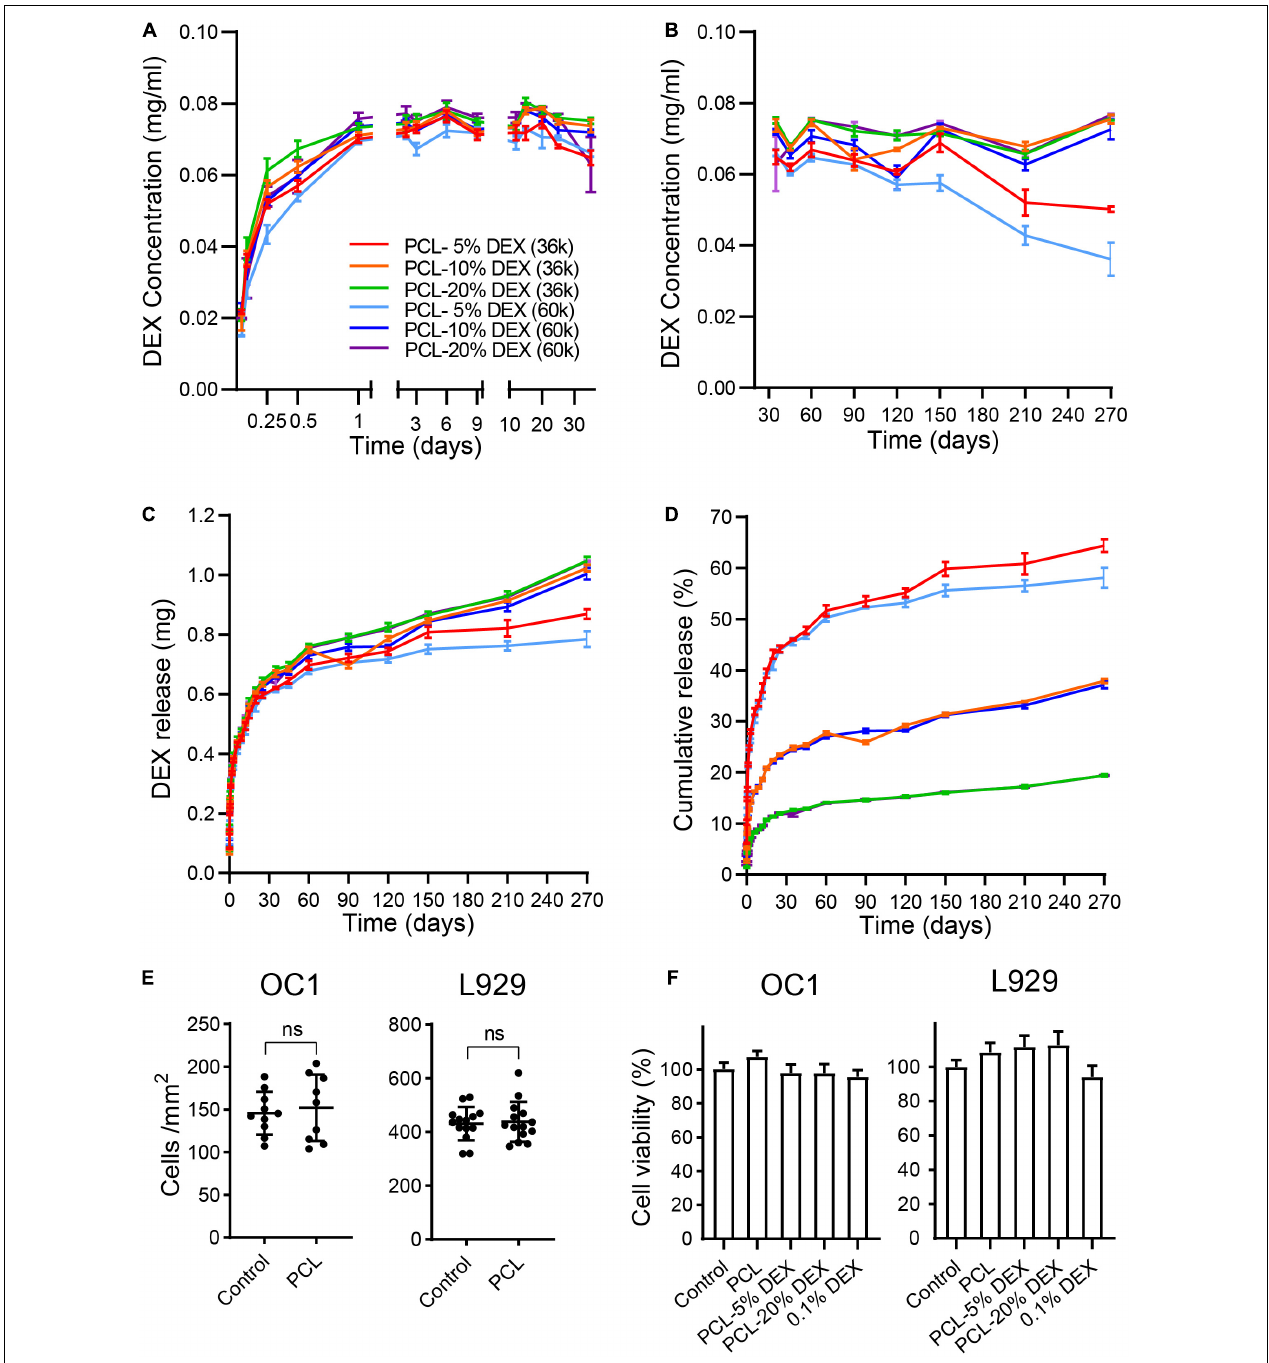
FIGURE 4 | The release of DEX. (A,B) The concentration of dexamethasone released by PCL-DEX-coated electrodes in artificial perilymph fluids each day in the short term [ (A) within 30 days] and long term [ (B) 30–270 days]. Color-coded lines indicate the electrodes coated with different molecular weights of PCL (MW36k or 60k) containing DEX from 5 to 20%. (C) Cumulative mass of DEX released by different PCL-DEX-coated electrodes in 3.6 ml of artificial perilymph fluids. DEX mass was measured from day 0 to 270. (D) The percentage of total DEX loaded in PCL released from day 0 to day 270 for different PCL-DEX formulas. The color code fits (A–D) . The data are presented as the mean ± SE. n = 10 for each group. (E) Cell density of HEI-OC1 cells and L929 cells cultured in PCL-coated and noncoated (control) plates. The data are presented as the mean ± SE. ns: no significant difference, p > 0.05, n = 10 for each group. (F) The cell viability of HEI-OC1 and L929 cells cultured in normal medium (control) and leach solution of PCL, PCL-5%DEX, PCL-10%DEX, and PCL-20% DEX and 0.1%DEX. The data are presented as the mean ± SE. n = 13 for OC1 cells and n = 23 for L929 cells.